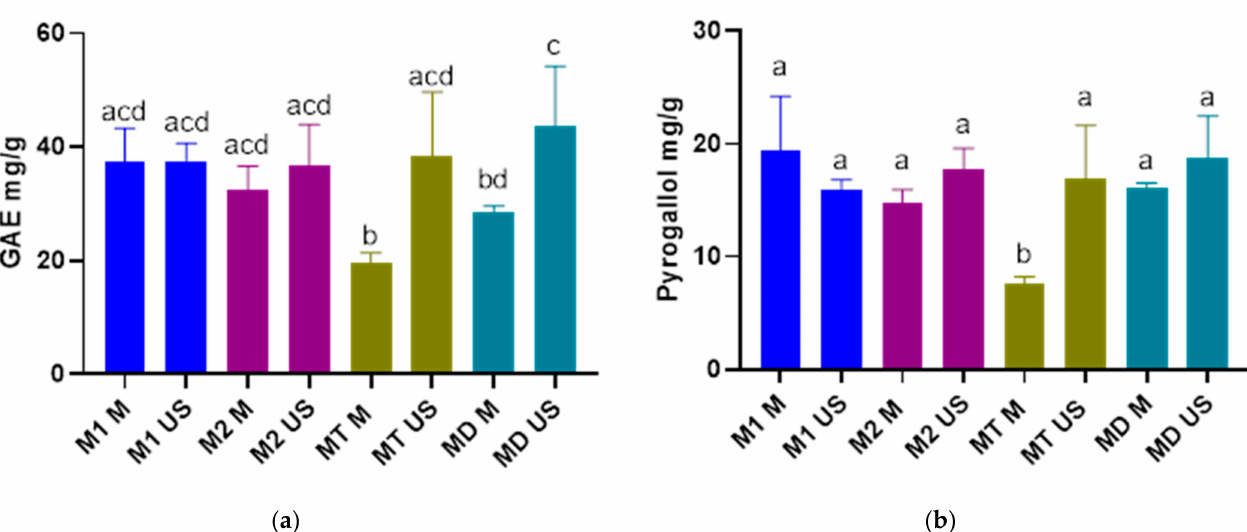
Figure 1. ( a ) Total polyphenol content (TPC) of spruce bark extracts; ( b ) total tannin content (TTC) of spruce bark extracts; significant differences are represented by different letters (significance level α = 0.05); M1 US— P. abies (Maramures ului , Mountains National Park site 1) extract produced by UAE, M2 US— P. abies (Maramures ului Mountains National Park site 2) , extract produced by UAE, MT US— P. abies (Tas ca) extract produced by UAE, MD US— P. abies (Dolhasca) extract produced , by UAE, M1 M— P. abies (Maramures ului Mountains National Park site 1) extract produced by MAE, M2 M— P. abies , (Maramures ului Mountains National Park site 2) extract produced by MAE, MT M— P. abies (Tas ca) extract produced by , , MAE and MD M— P. abies (Dolhasca) extract produced by